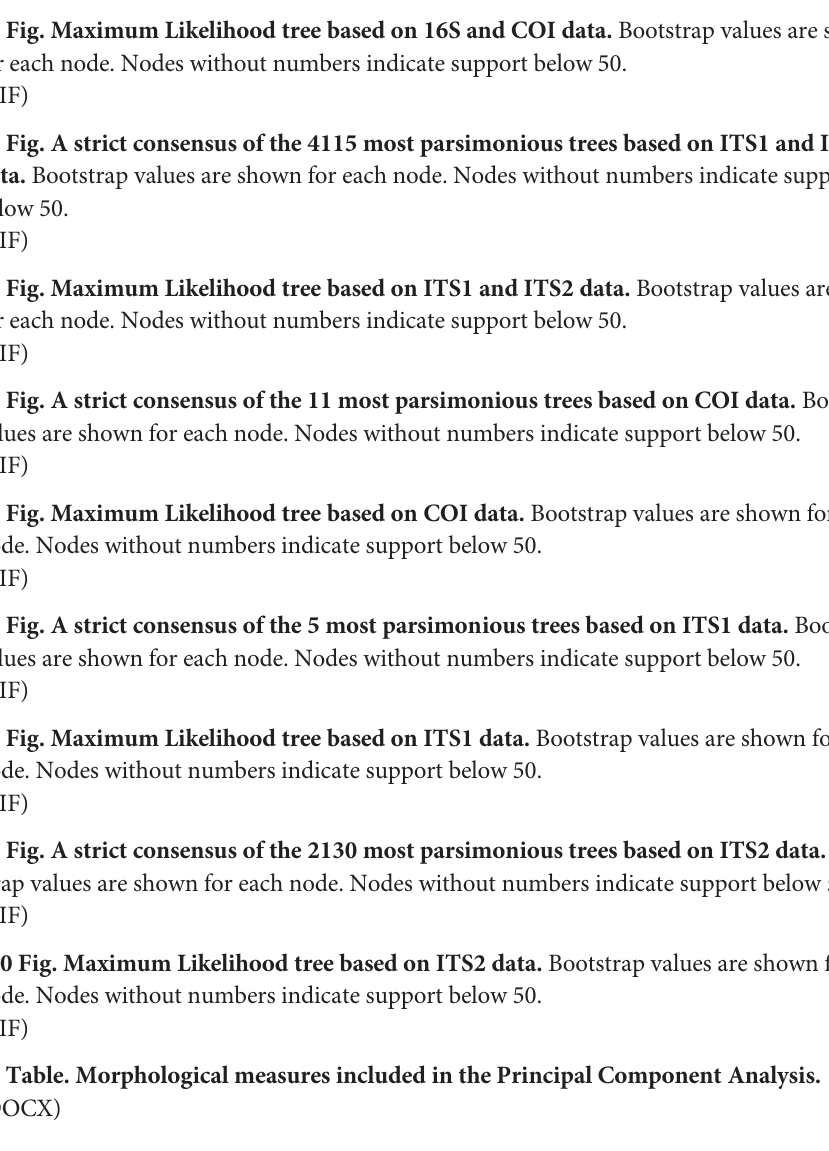
Bootstrap values are shown for each node. Nodes without numbers indicate support below 50. S2 Fig. Maximum Likelihood tree based on 16S and COI data. Bootstrap values are shown for each node. Nodes without numbers indicate support below 50. S3 Fig. A strict consensus of the 4115 most parsimonious trees based on ITS1 and ITS2 data. Bootstrap values are shown for each node. Nodes without numbers indicate support below 50. S4 Fig. Maximum Likelihood tree based on ITS1 and ITS2 data. Bootstrap values are shown for each node. Nodes without numbers indicate support below 50. S5 Fig. A strict consensus of the 11 most parsimonious trees based on COI data. Bootstrap values are shown for each node. Nodes without numbers indicate support below 50. S6 Fig. Maximum Likelihood tree based on COI data. Bootstrap values are shown for each node. Nodes without numbers indicate support below 50. S7 Fig. A strict consensus of the 5 most parsimonious trees based on ITS1 data. Bootstrap values are shown for each node. Nodes without numbers indicate support below 50. S8 Fig. Maximum Likelihood tree based on ITS1 data. Bootstrap values are shown for each node. Nodes without numbers indicate support below 50. S9 Fig. A strict consensus of the 2130 most parsimonious trees based on ITS2 data. Boot- strap values are shown for each node. Nodes without numbers indicate support below 50. S10 Fig. Maximum Likelihood tree based on ITS2 data. Bootstrap values are shown for each node. Nodes without numbers indicate support below 50. S1 Table. Morphological measures included in the Principal Component Analysis.